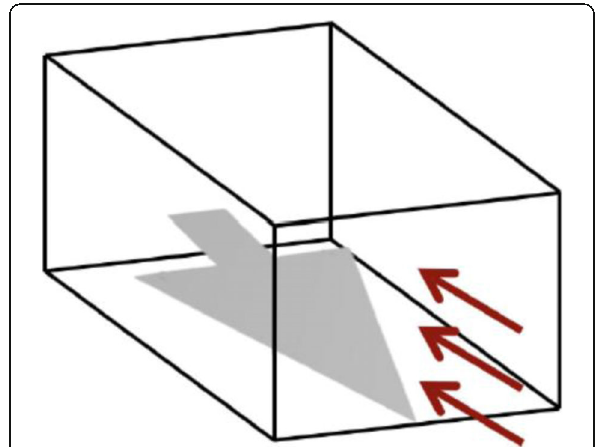
Fig. 6 3D space of flow